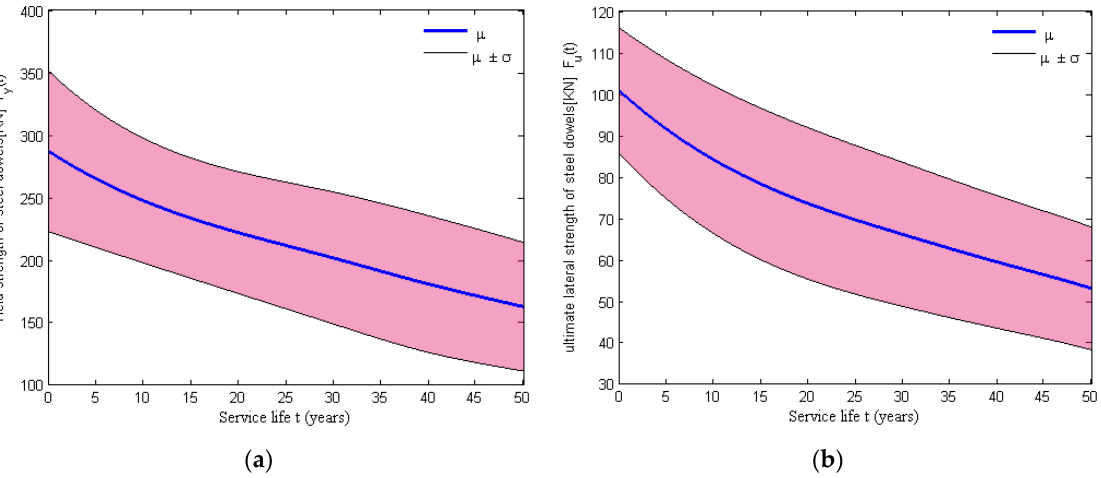
Figure 11. Time evolution of the ( a ) yield strength and ( b ) ultimate lateral strength for swedged steel dowels